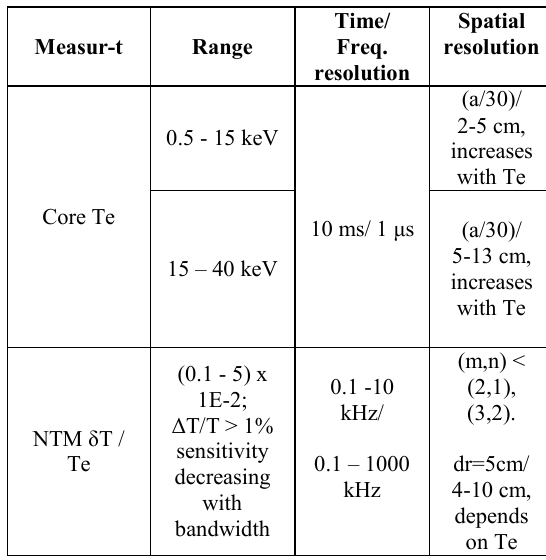
Table 1. Expanded table of ITER ECE diagnostic specifications for primary role